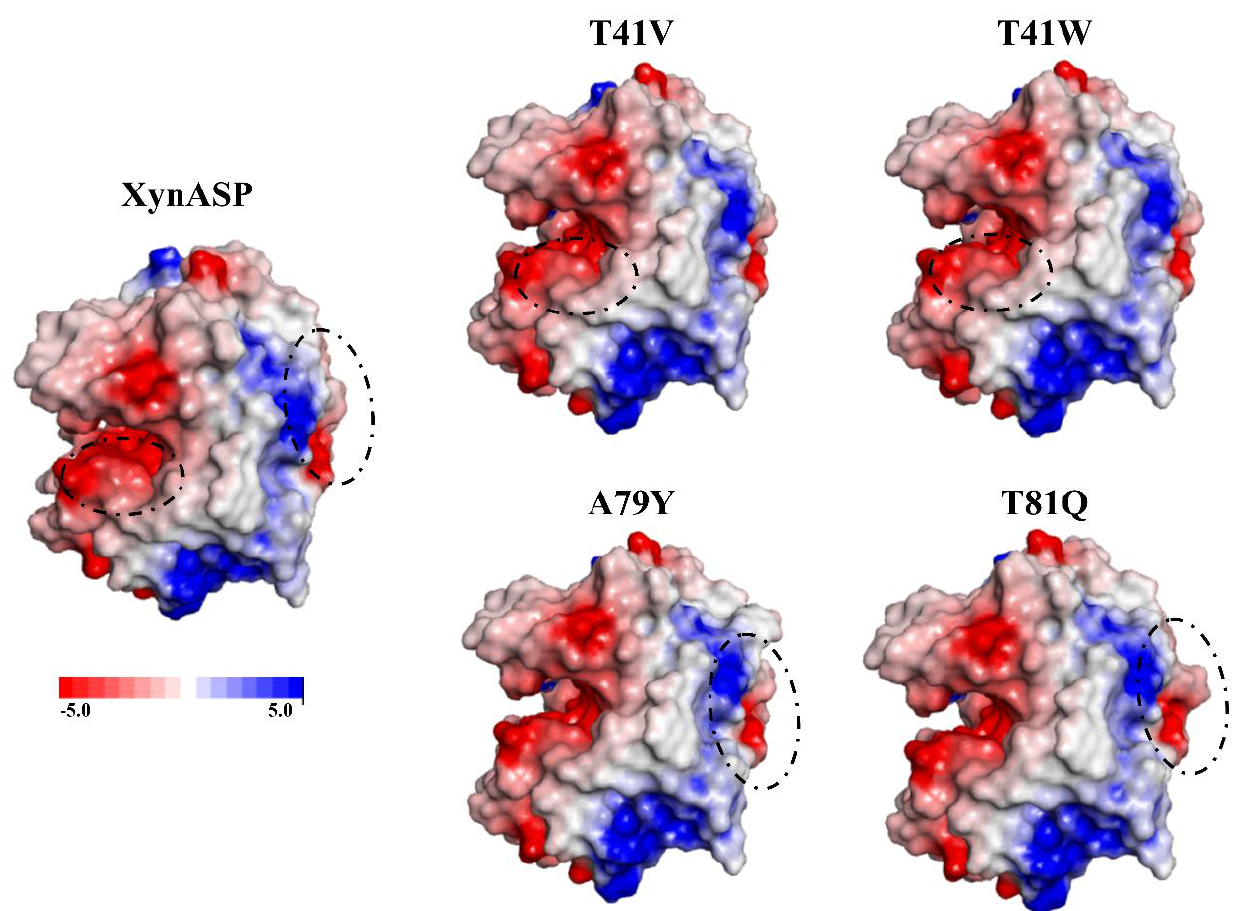
Figure 5. Electrostatic properties of the wild-type XynASP and single mutants. The electrostatic potential surface of enzymes calculated by Discovery Studio 3.0 was shown using the PyMOL. The black dotted ring on the wild-type XynASP and single four mutants represent the region of mutated sites.